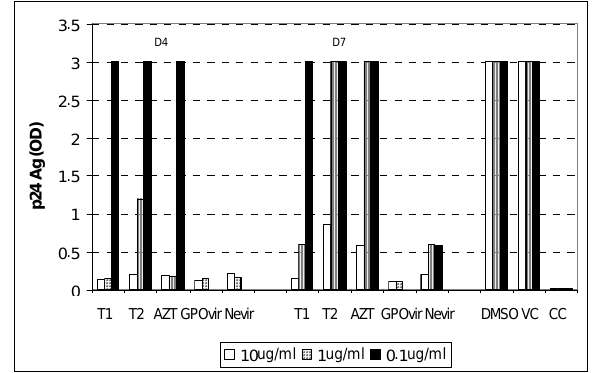
Figure 2. T1 exhibited comparable virustatic activity to that of AZT, GPOvir and nevirapine at concentration of 1 µ g/mL on the fourth day. On the seventh day, T1 exhibited comparable activity to that of nevirapine at a concentration of 1 µ g/mL and to that of GPOvir at 10 µ g/mL, but showed higher activity than AZT at 1 µ g/mL. T2 was less potent than T1 (~6-fold) at concentration of 1 µ g/mL. Figure 2 . Virustatic activity of T1 and T2 observed in seven days.